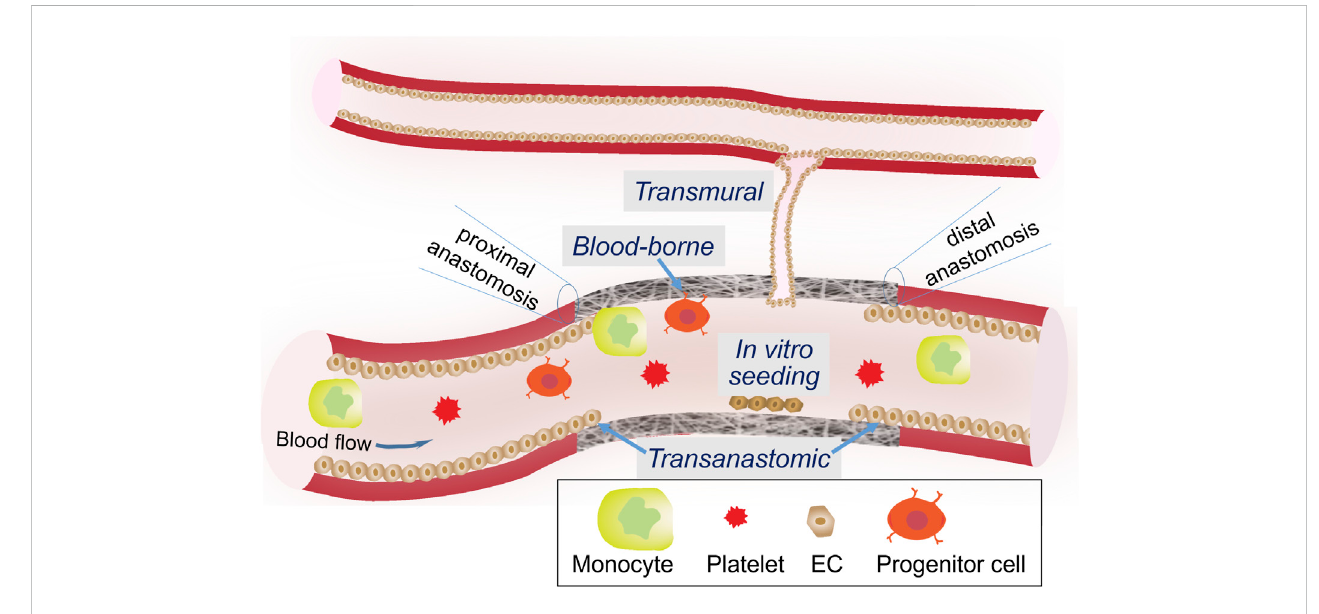
FIGURE 4 Possible mechanisms underlying graft